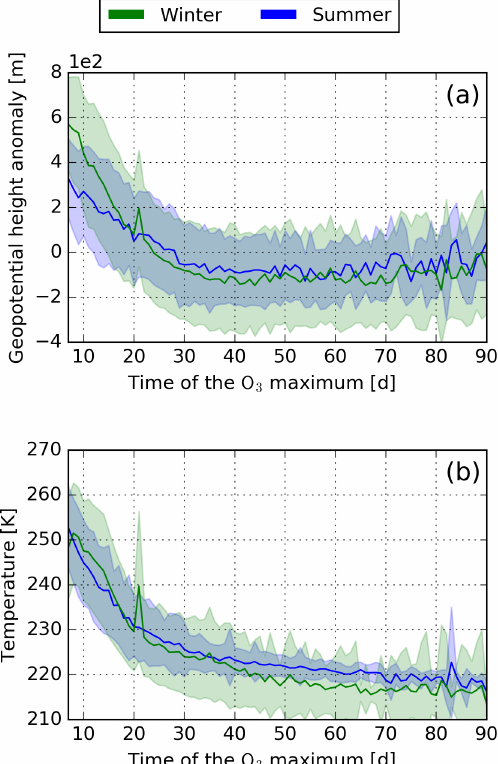
Figure 5. (a) Mean 250hPa geopotential height anomaly. The mean is calculated for the first 7d after emission, similar to the mean val- ues given in Fig. 4. The anomaly is calculated based on the seasonal mean. (b) Mean dry air temperature. Here, the mean is calculated based on the time between emission and the O 3 maximum. Both parameters are given in relation to the time of the O 3 maximum. The seasonal mean is represented by the solid line and the standard deviation as shaded